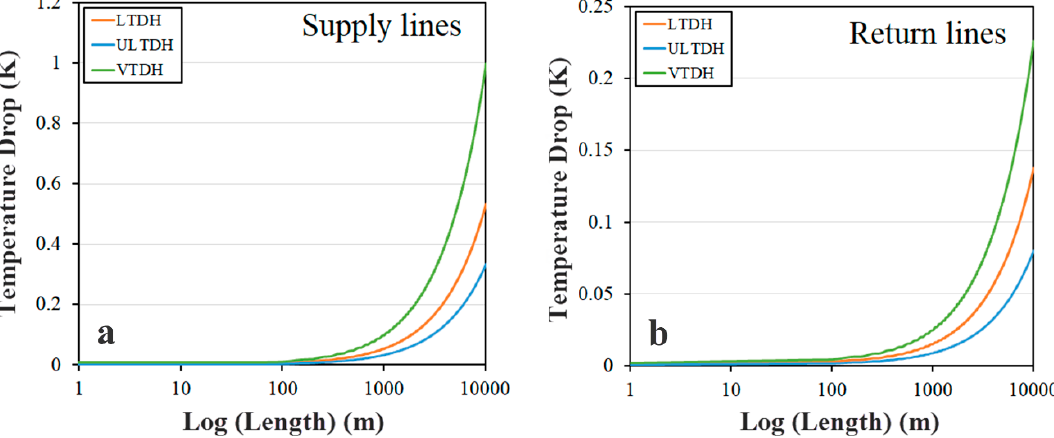
Figure 5. Contours of radial temperature distribution for the pipes through the insulations. ( a ) Low- Temperature DH systems; ( b ) Ultralow-Temperature DH system; ( c ) Variable-Temperature DH system.